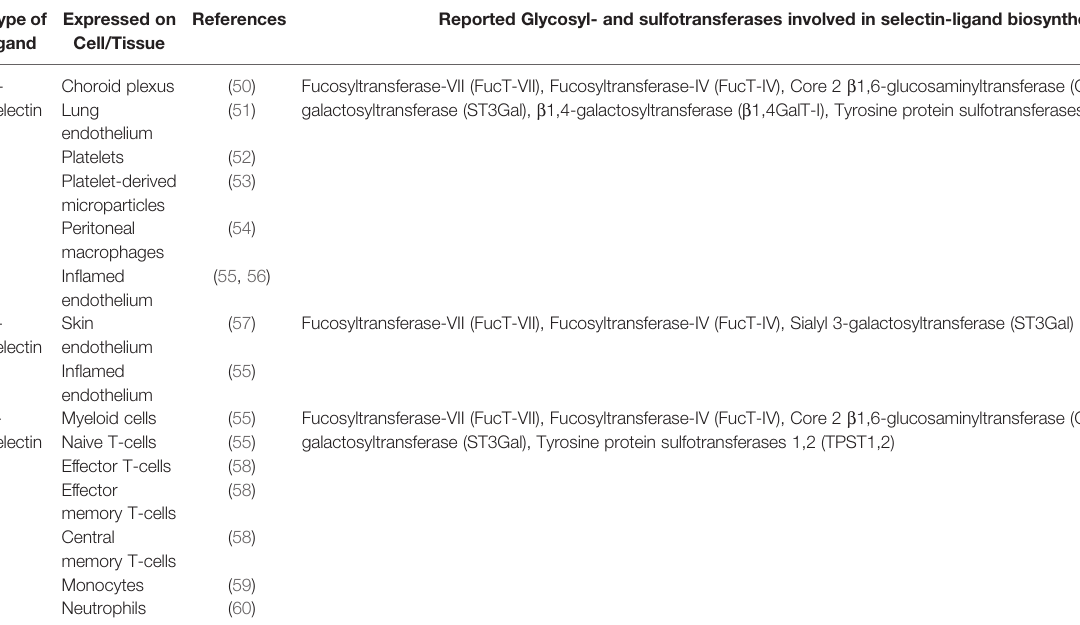
TABLE 1 | Selectins expression and the enzymes required for PSGL-1 binding. Reported Glycosyl- and sulfotransferases involved in selectin-ligand